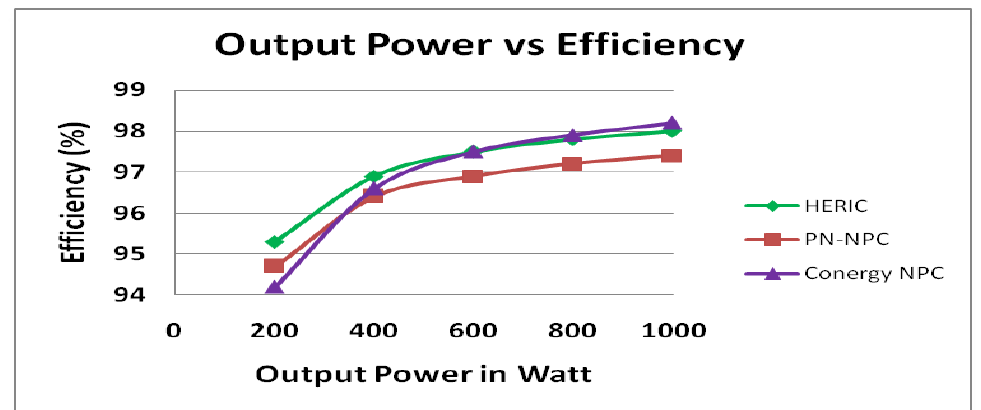
In Figure 26, the output power versus efficiency curve for three chosen topolo- gies — one from each category — is displayed.